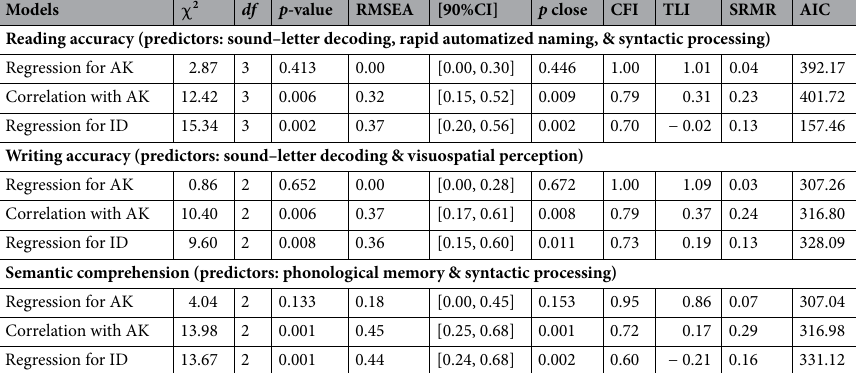
Table 4. Results of path analyses that test models including kanji abilities, their cognitive underpinnings, and higher-level language skills. Note: n = 30. χ 2 chi-square statistic, df degree of freedom of χ 2 distribution, p-value significance in χ 2 test, RMSEA root mean square error of approximation, 90%CI 90% confidence interval